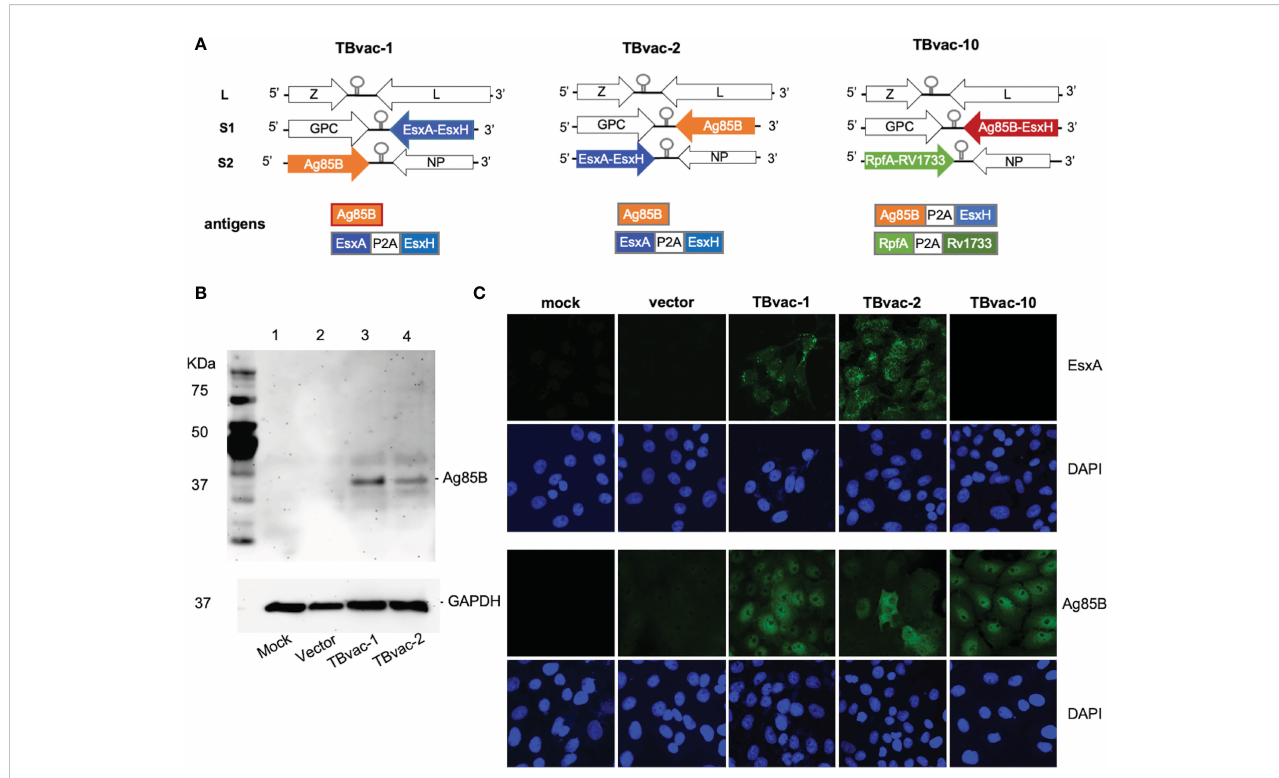
FIGURE 1 Generation of rP18tri-based viral vector vaccines encoding Mtb antigens. (A) Genomic organization of the viral vectored TB vaccines (TBvac-1, TBvac-2 and TBvac-10), with the inserted Mtb antigens shown below. The P2A linker sequence was used to express two antigens from one ORF. (B) Detection of Mtb Ag85B antigen expression by Western blotting. Vero cell lysates collected 24 hours after mock infection or infection with vector, TBvac-1, or TBvac- 2 were analyzed by Western blotting with anti-Ag85B and anti-GAPDH antibodies. (C) Detection of Mtb antigen expression in the infected Vero cells by IFA with anti-ESAT-6 and anti-Ag85B